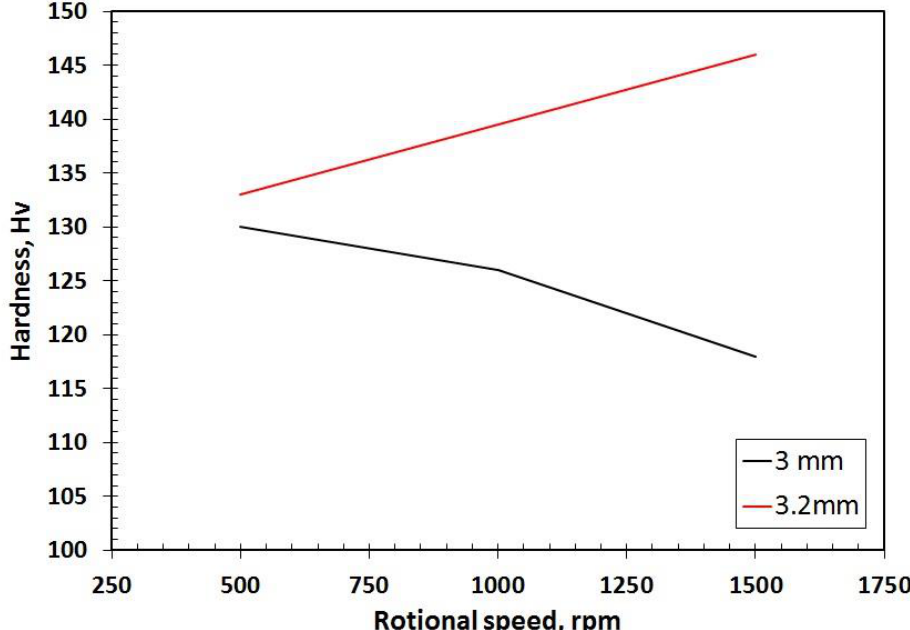
Figure 16. The relationship between hardness, rotation speed, and pin lengths.